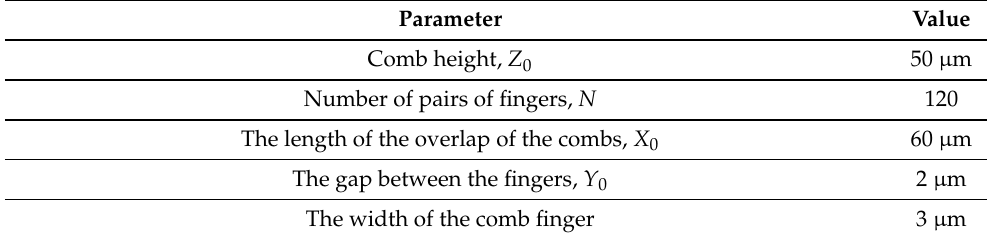
Table 3. Parameters of the comb counter-pin